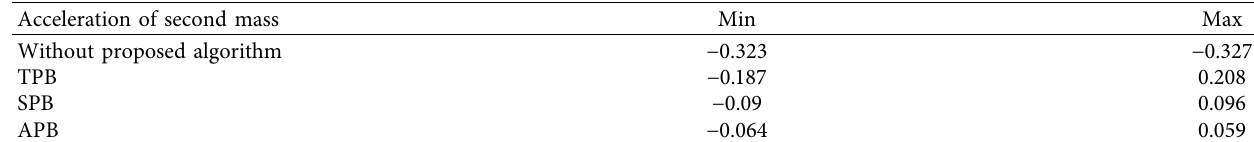
Table 2: Comparative results of experimental laboratories.